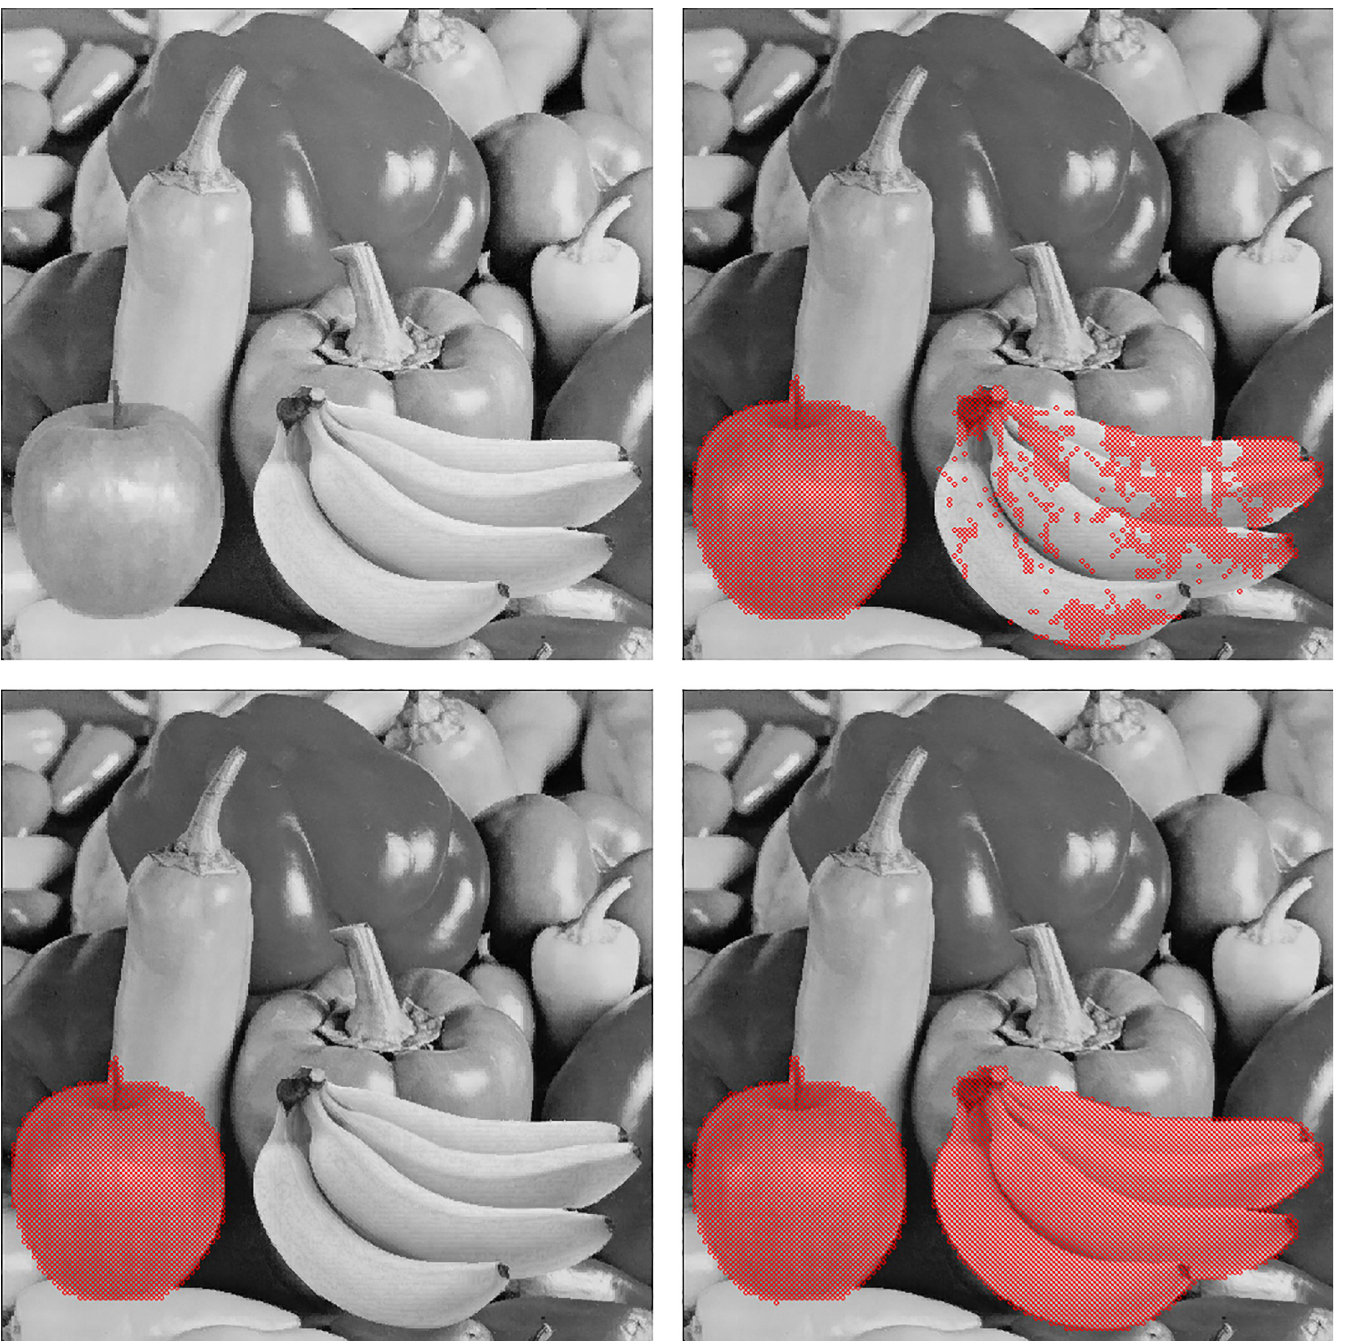
Fig 11. Detectability comparisons of the proposed and other methods. (a) Detection results of [18]. (b) Detection results of [16]. (c) Detection results of [17]. (d) Detection results of the proposed